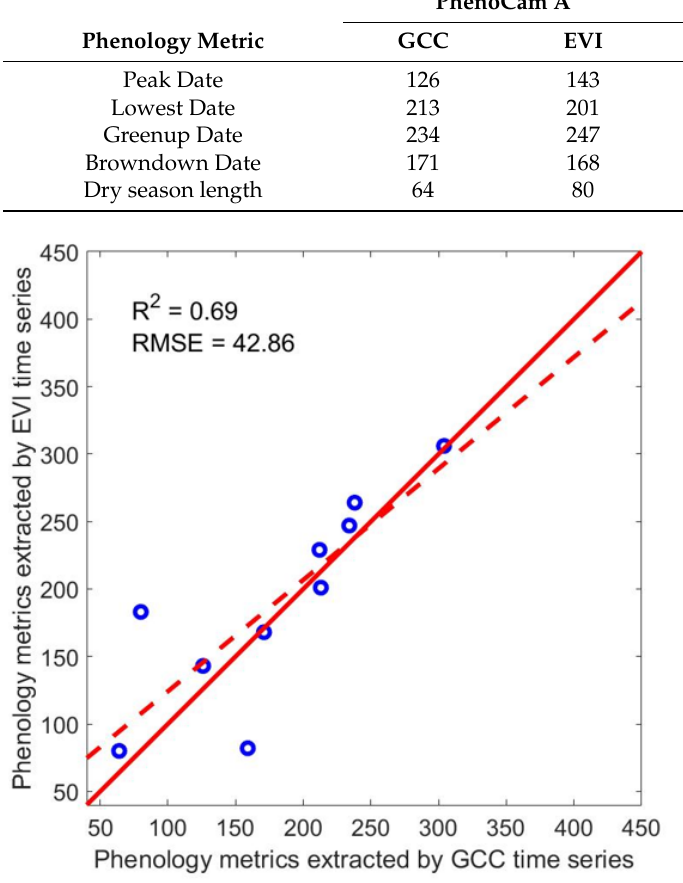
Figure 11. Comparison between phenology metrics derived from Landsat EVI time series and that from the two PhenoCam sites in the tropical dry forest zones of Puerto Rico, including 5 phenology metrics: peak date, lowest date, greenup date, browndown date, and dry season length.